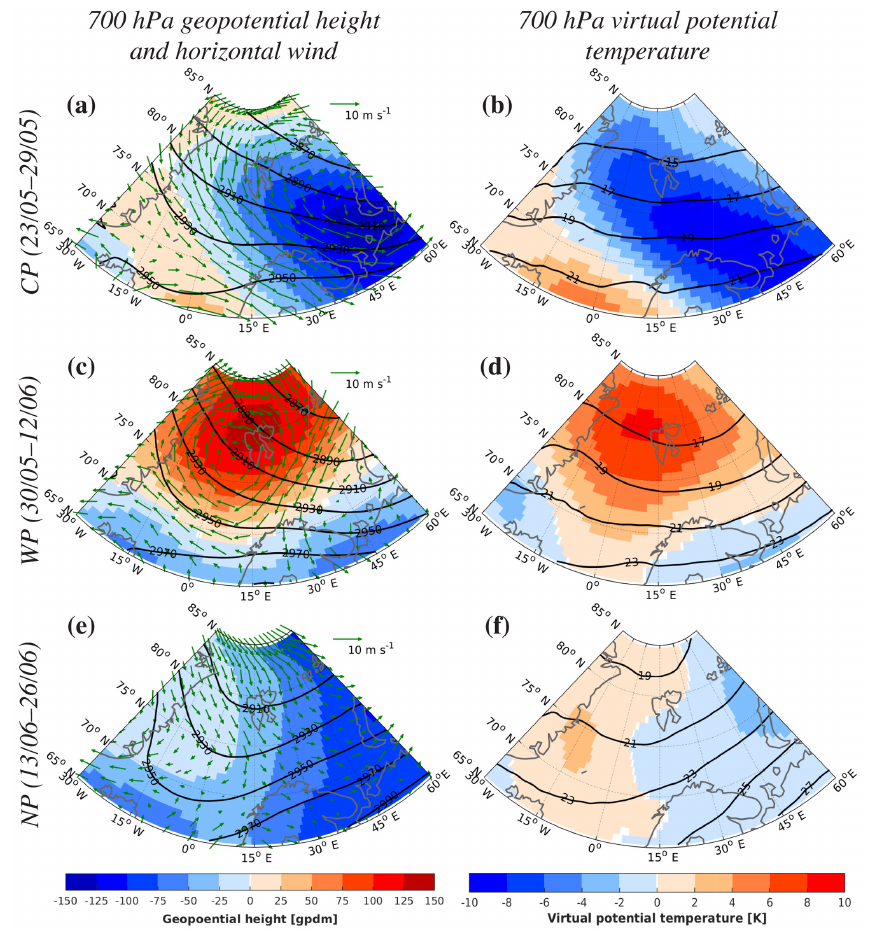
Figure 9. Climatologies (1979–2016; contours) and anomalies relative to climatologies (2017 minus 1979–2016; shading) of 700hPa (a, c, e) geopotential height with key period median horizontal wind (vectors) and (b, d, f) virtual potential temperature for each ACLOUD/PASCAL key period based on ERA-I data. Key periods are defined as (a, b) the cold period (CP), (c, d) the warm period (WP), and (e, f) the normal period